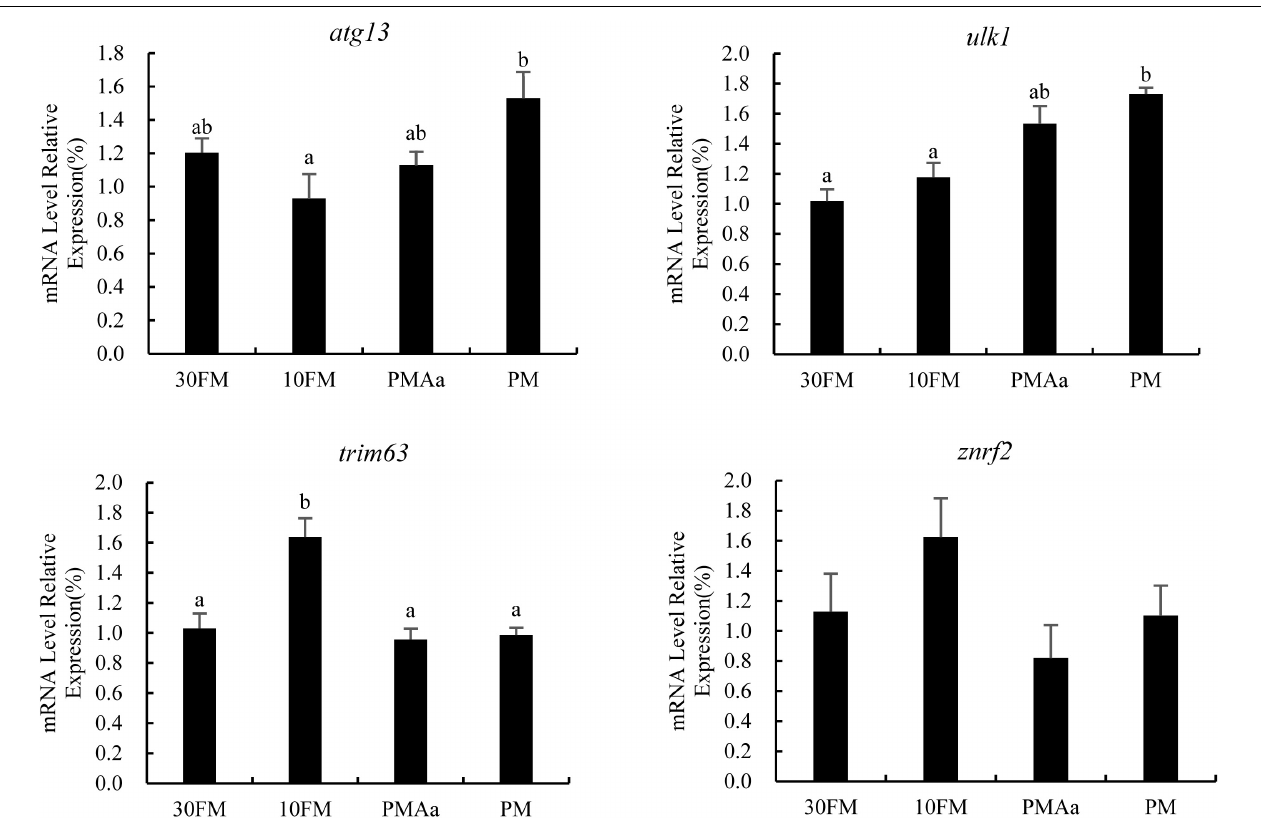
FIGURE 2 | Relative expression of protein degradation genes ( atg13 , ulk1 , trim63 , and znrf2 ) in the muscle of gibel carp β -actin and ef1 α was used as reference gene for the assessment of expression. Columns represent the mean ± SEM ( n = 6). For each index, bars without sharing a common letter indicate significant differences ( p <